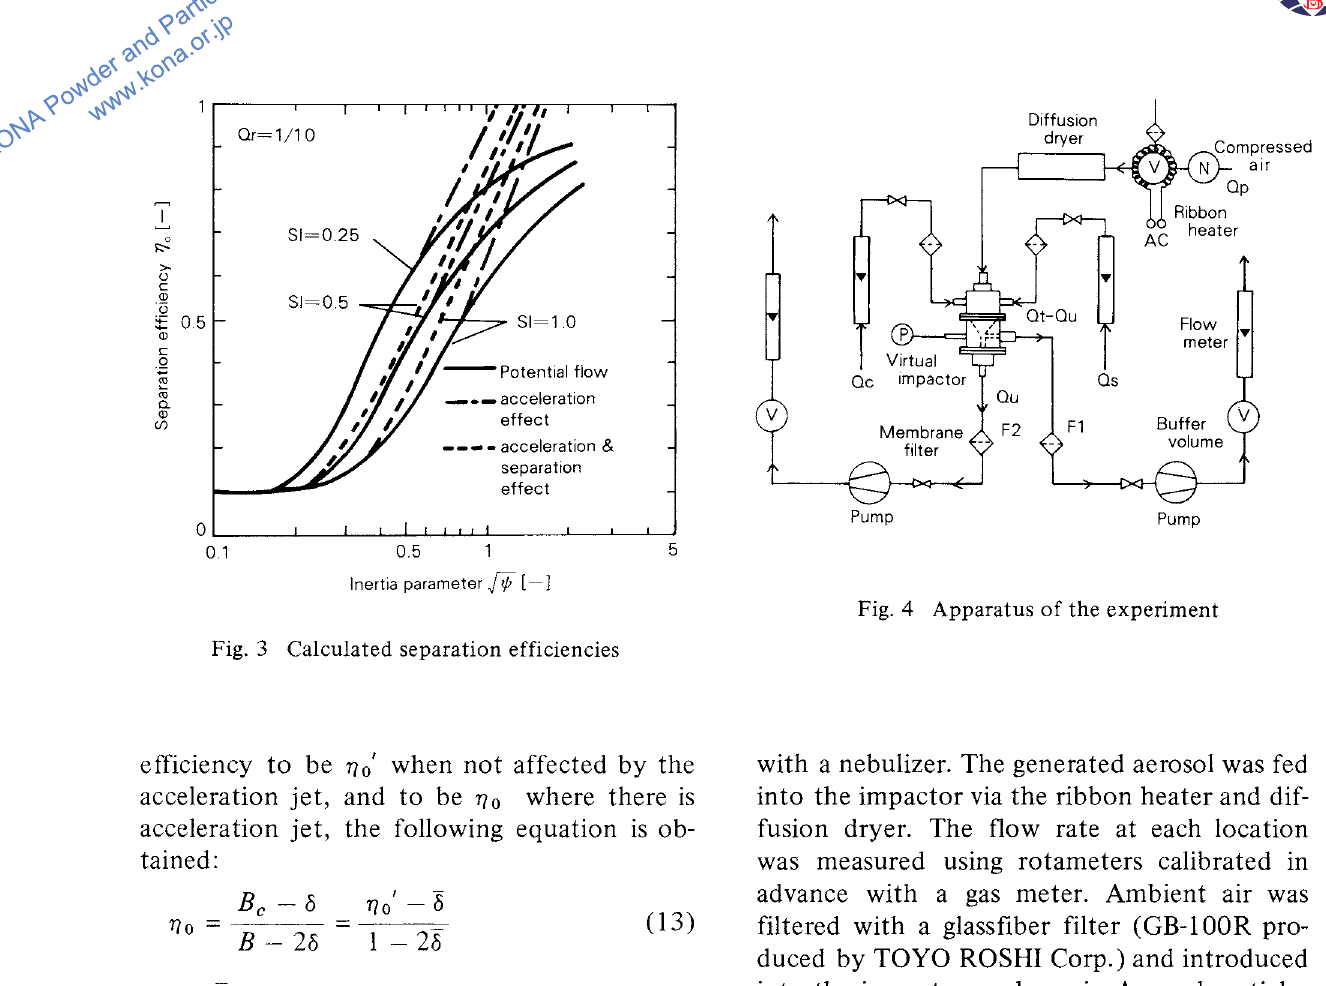
5 Fig. 4 Apparatus of the